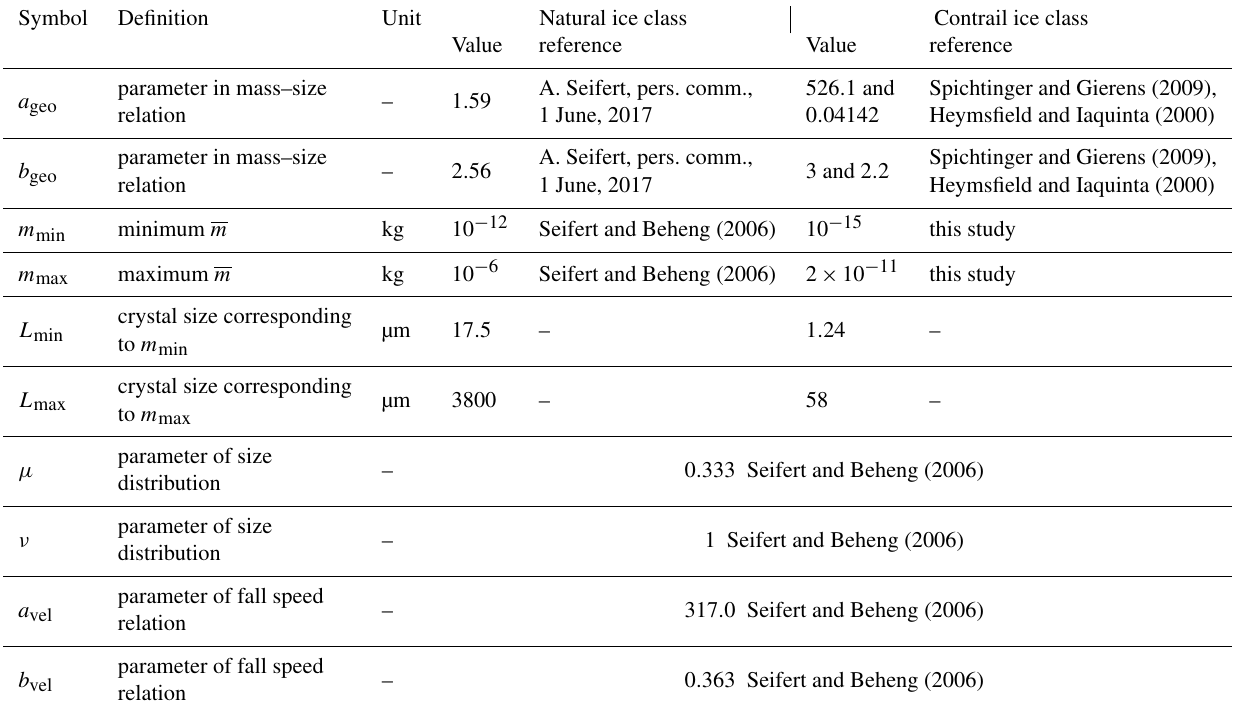
Table A1. Constants characterizing the natural and the contrail ice